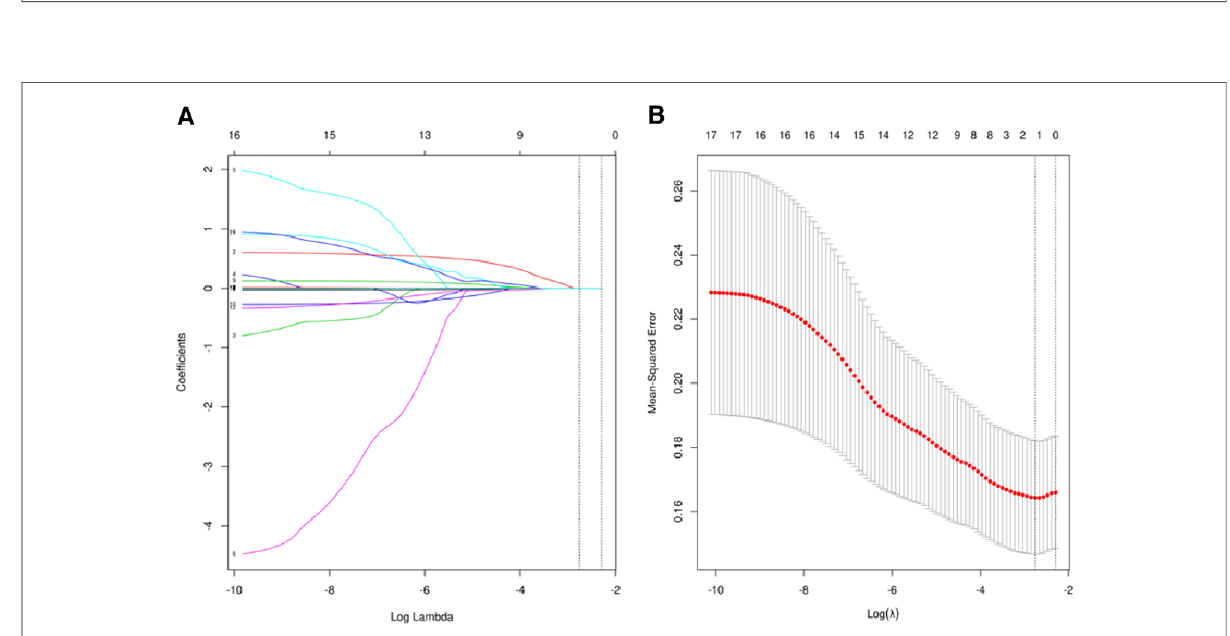
FIGURE 2 ( A ) regression analysis of in fl uence factors based on Lasso for variable selection; ( B ) cross-validation of the regression